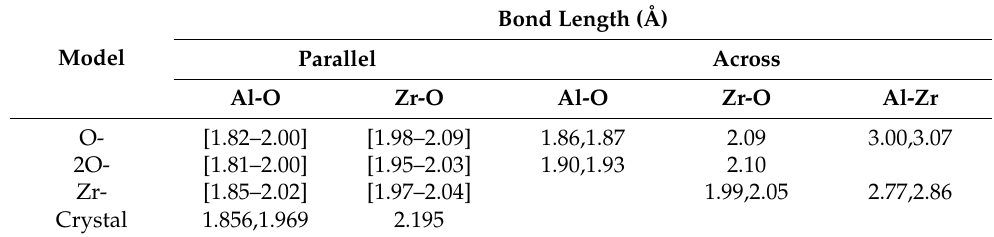
Table 1. Bond lengths (Å) of the three models in the interface region.